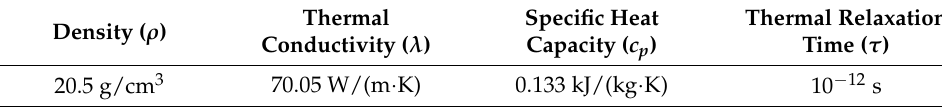
Table 1. Related parameters of Pt–Rh alloy with a rhodium content of 10%.